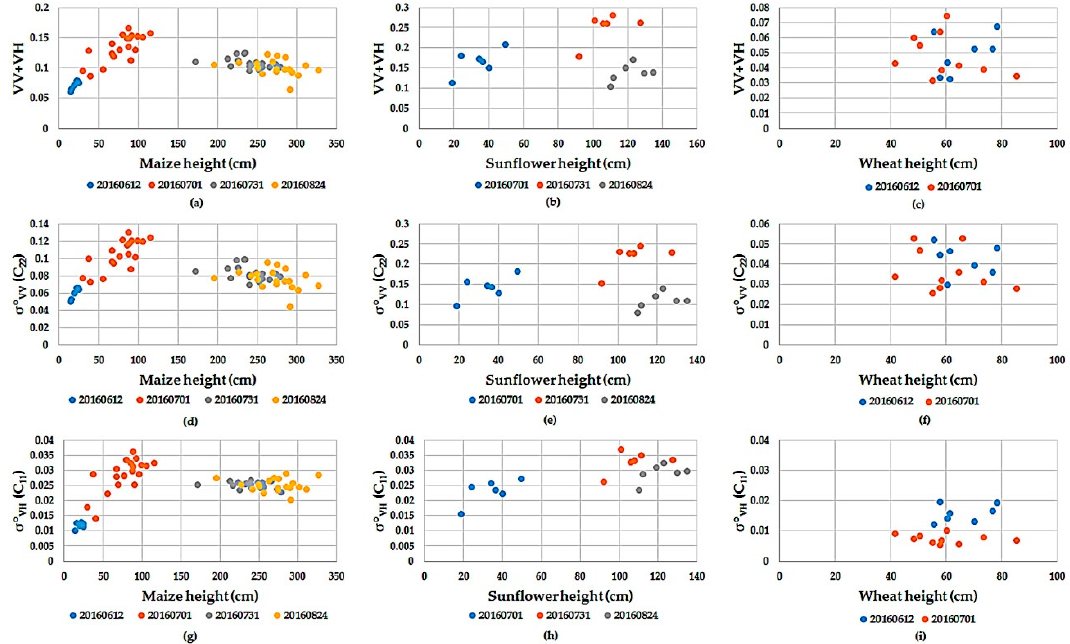
Figure 8. Correlation between ( a – c ) intensity arithmetic calculation of VV + VH, ( d – f ) σ 0 VV backscatter, and ( g – i ) σ 0 VH backscatter values of maize, sunflower and wheat with their height during growing stages.